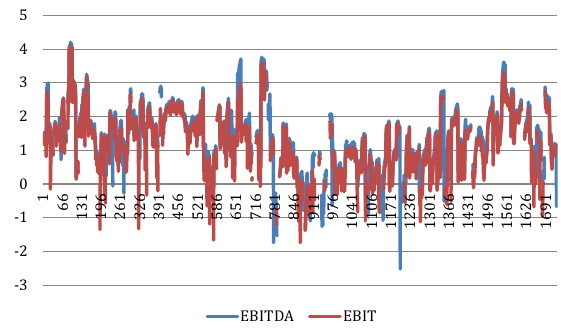
Fig. 1 The both pro fi tability measures, EBITDA and EBIT, attempt to represent the cash pro fi t generated by the fi rm ’ s operation. This indicates that the fl uctuations of EBITDA and EBIT re fl ect the fl uctuations in the fi rm ’